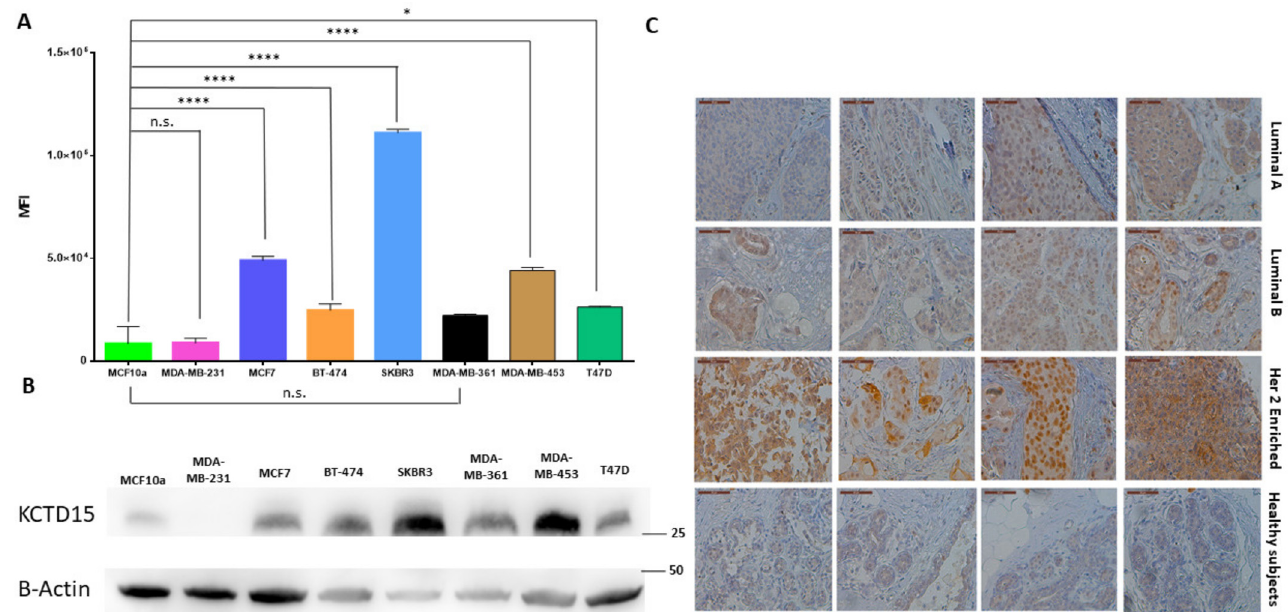
Figure 2. KCTD15 expression in breast cancer tissues and cell lines. ( A ) Bar-plots display flu- orescence intensity (in terms of median of fluorescence and SEM) of KCTD15 in MCF10 (light green), MDA-MB-231 (pink), MCF7 (blue), BT-474 (orange), SKBR3 (light blue), MDA-MB-361 (black), MDA-MB-453 (light brown) and T47D (green). The error bar represents SEM. **** = p < 0.0001, * = p < 0.05. Mann Whitney T-test. Panel ( B ) shows KCTD15 expression using WB. Numbers represent protein marker expressed in kDa. Western blot is representative of three independent experiments with similar results. Panel ( C ) displayed KCTD15 expression level in breast tissues by IHC analysis: 4 Luminal A (score 2), 4 Luminal B (score 2), 4 HER2 enriched (score 3), and 4 healthy subtypes (score 0). Magnification 40 × . Scale bars 50 µ